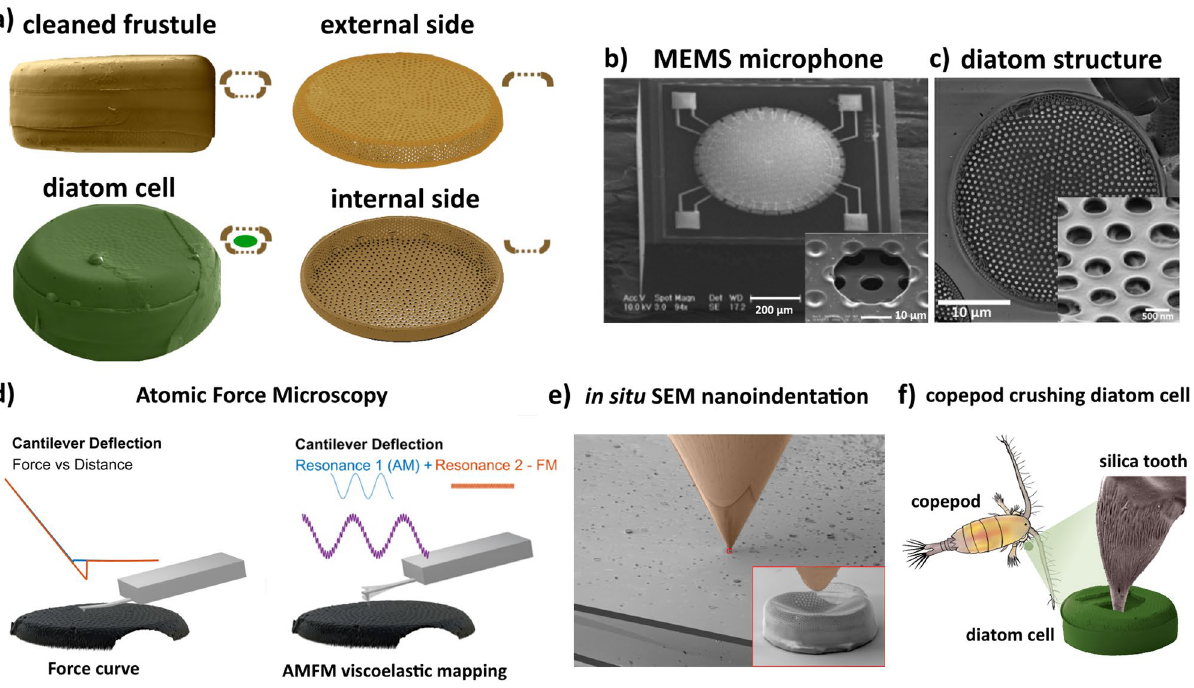
Figure 1. Study objects, biomimetic approach and research methodology. ( a ) Samples used in this study: cleaned frustule (organic matter removed), external and internal sides of cleaned frustules, diatom cell containing organic components, ( b ) SEM images of the MEMS microphone and the membrane perforation (inset). Adapted with a permission from 12 . ( c ) SEM image of diatom frustule showing the porous structure (inset), ( d ) Schematic diagrams of two modes of AFM measurement: force vs distance and amplitude modulation-frequency modulation (AMFM), ( e ) In situ nanoindentation inside SEM column, ( f ) Schematic illustration of a copepod crushing diatom cell with the help of a silica tooth as an example of indentation in